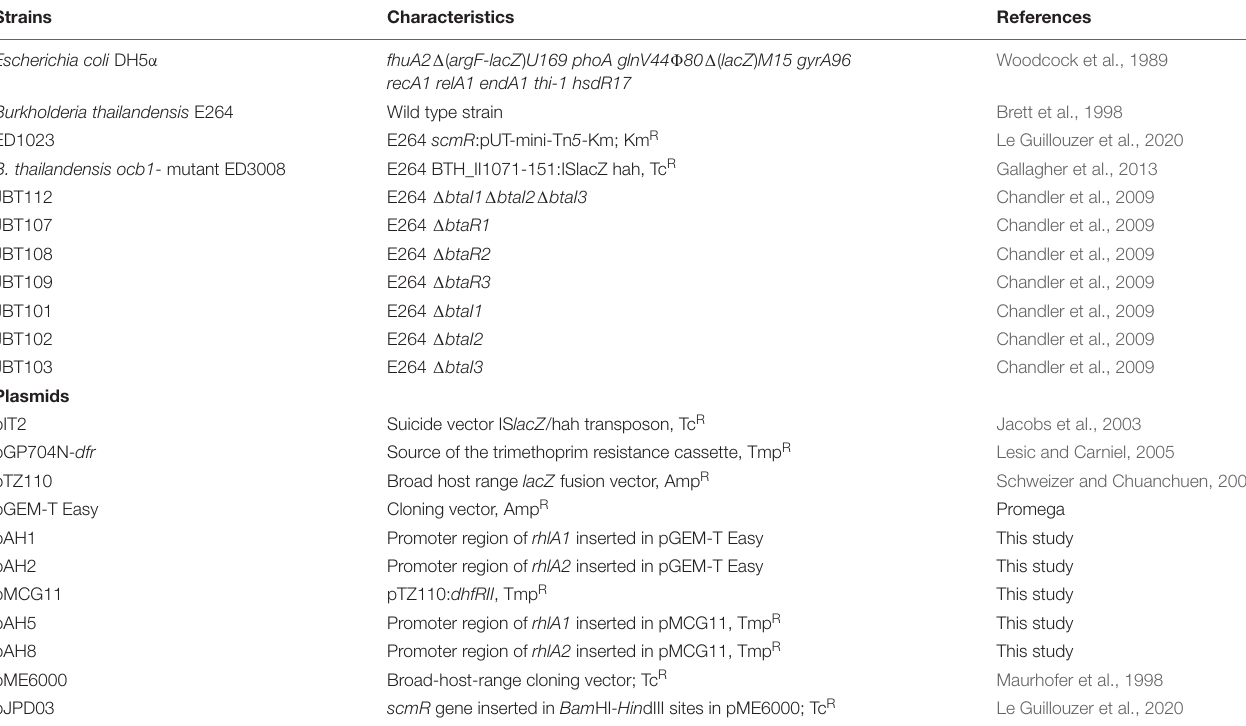
TABLE 1 | Strains and plasmids used in this